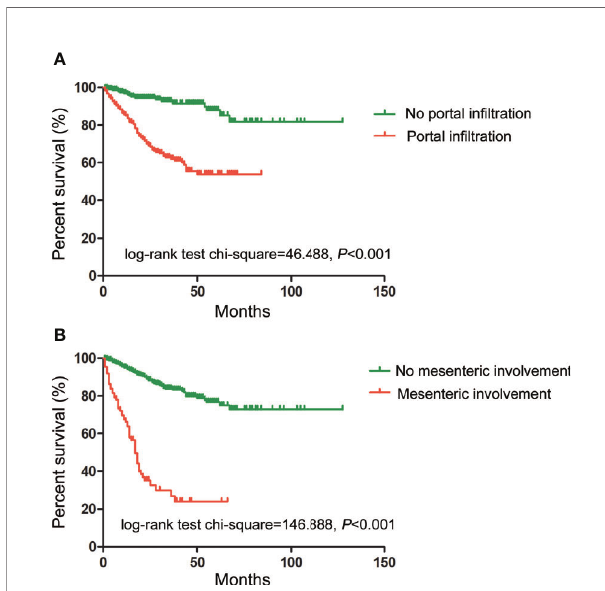
FIGURE 4 | Prognostic impact of portal in fi ltration and mesenteric involvement as detected by US on survival outcomes. (A) The log-rank test of survival showed that patients with portal in fi ltration had lower survival duration (in months) than patients with no portal in fi ltration. ( c 2 = 46.488, p < 0.001). (B) The log-rank test of survival showed that patients with mesenteric involvement also had lower survival duration than those without mesenteric involvement. ( c 2 = 146.888, p < 0.001).